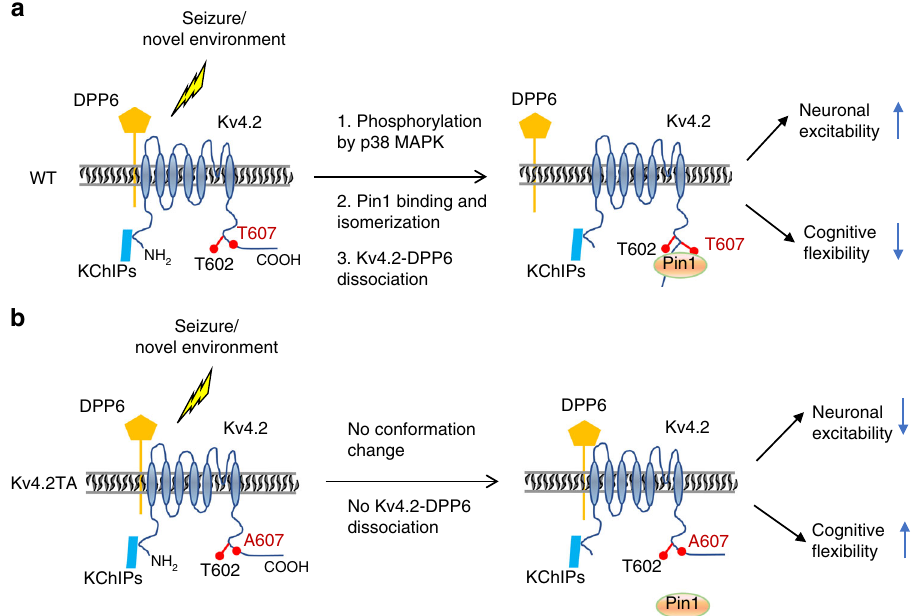
Fig. 8 Working model of Pin1-dependent Kv4.2-DPP6 complex remodeling that underlies neuronal excitability and cognitive in fl exibility. a In WT mice, stimulations such as seizure and exposure to a novel environment trigger the phosphorylation of Kv4.2 at T607, which allows Pin1 binding to pT602 and pT607 which subsequently isomerizes the pT607-P bond. This process changes the conformation of Kv4.2, which dissociates the Kv4.2-DPP6 complex and increases neuronal excitability and cognitive in fl exibility. b In Kv4.2 TA mice, the 607 site is no longer phosphorylatable so that Pin1 ’ s effect on Kv4.2 is abolished. The Kv4.2-DPP6 complex is stable, neuronal excitability is reduced, and cognitive fl exibility is